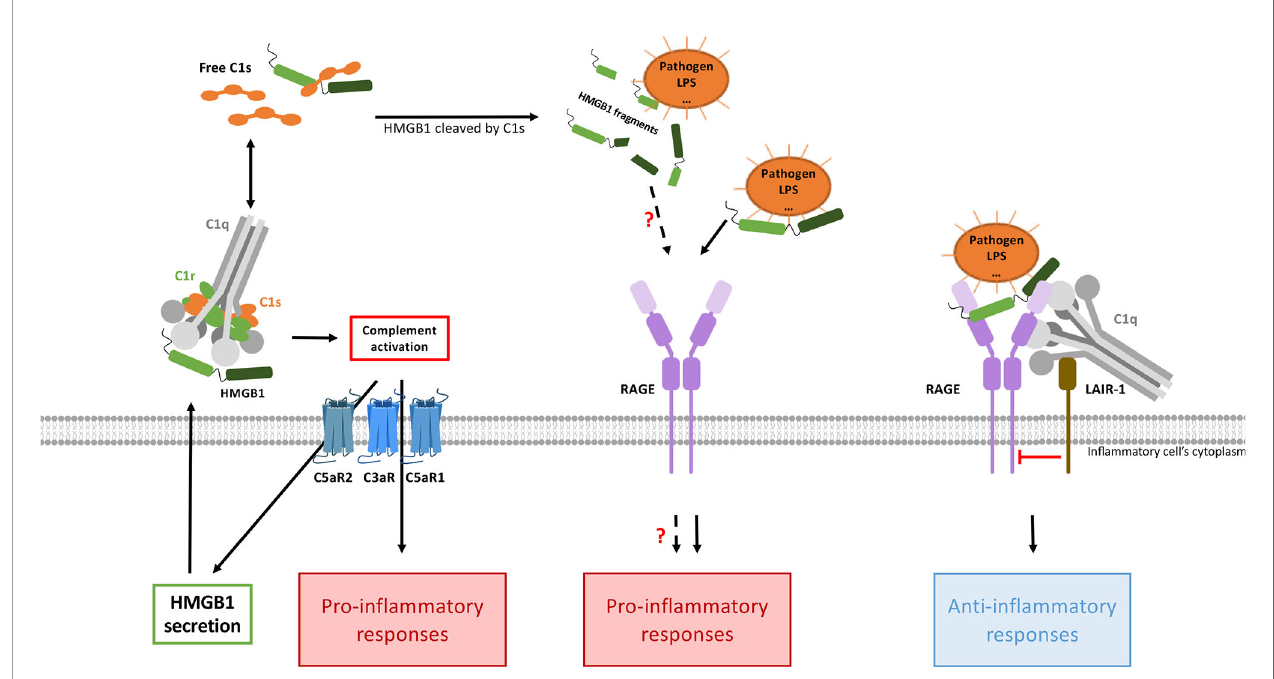
FIGURE 4 | HMGB1 and complement interplays combine pro- and anti-in fl ammatory responses. CP activation (possibly directly mediated by HMGB1) will produce anaphylatoxins, which enhance HMGB1 secretion (left). In this context, the pro-in fl ammatory responses triggered by the two pathways are additive and cross- ampli fi ed. On the other hand (right), when C1q bridges LAIR-1 and HMGB1-RAGE, then LAIR-1 recruits the SHP-1 phosphatase which will shut down the RAGE- mediated in fl ammatory signaling, thereby dampening in fl ammation. Activated C1s can also cleave HMGB1, but the functional impact of the HMGB1 cleavage fragments need to be investigated. By inhibiting HMGB1internalization through RAGE (not shown here), C1q can also limit the extent of intracellular TLR